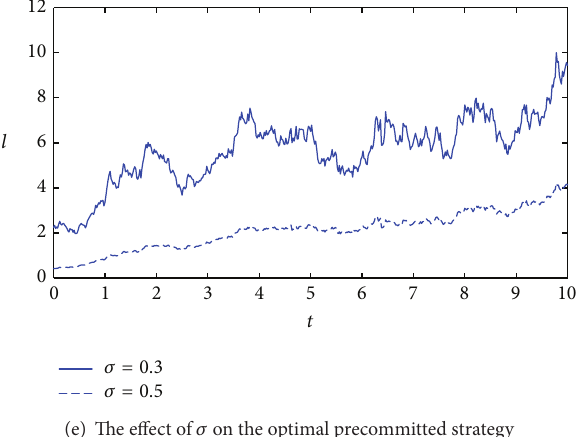
Figure 2: The effect of parameters on the optimal precommitted